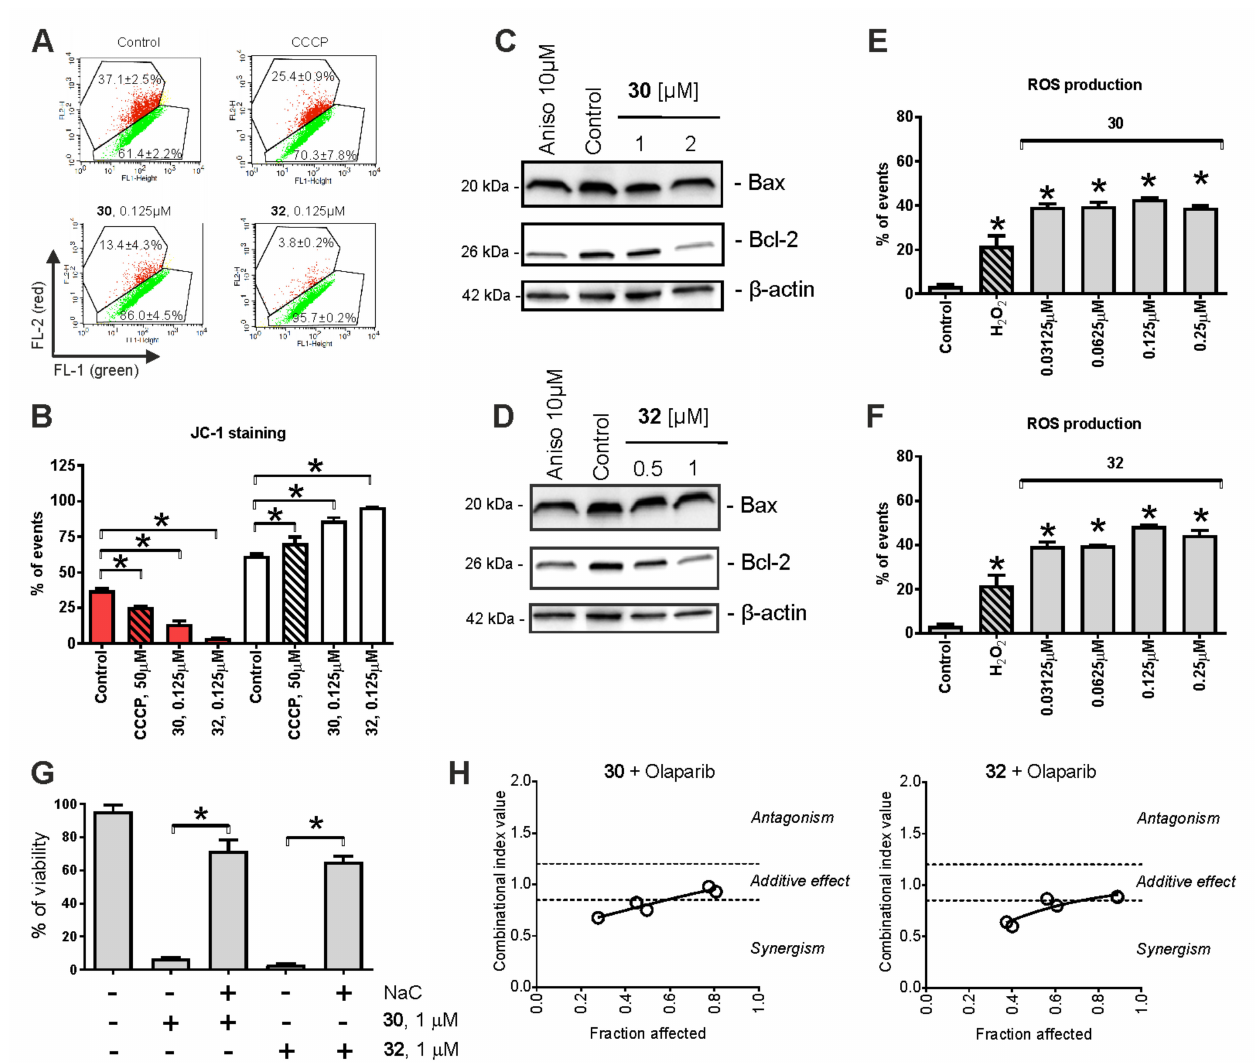
Figure 3. Effect of 30 and 32 on mitochondria of prostate cancer cells. ( A , B ) The induction of ∆Ψ m loss (mitochondrial membrane potential) by the drugs. 22Rv1 cells were treated for 2 h with the tested compounds and stained with JC-1, followed by flow cytometry analysis ( A ) and data quantification ( B ). The results indicate a drop in red fluorescence intensity, suggesting drug-induced depolarization of mitochondria. Cells showing ∆Ψ m loss have been quantified using Cell Quest Pro software ( B ). Cells treated with 50 µ M CCCP for the indicated time were used as a positive control. ( C , D ) Western blotting analysis of Bax and Bcl-2 expression in 22Rv1 cells following 48 h drug exposure. ( E , F ) Effects on the ROS